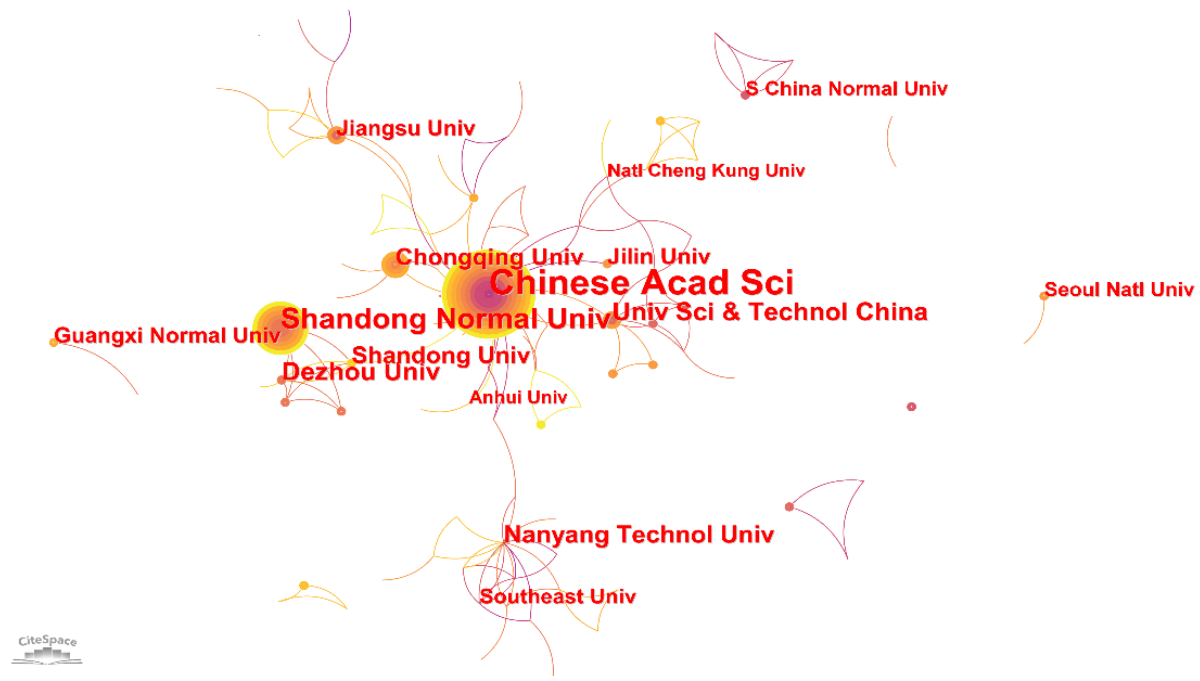
Figure 7. The institution cooperation network of published papers for graphene ‐ based SERS. Table 3. A list of the top 7 institutions using centrality order for graphene ‐ based SERS.